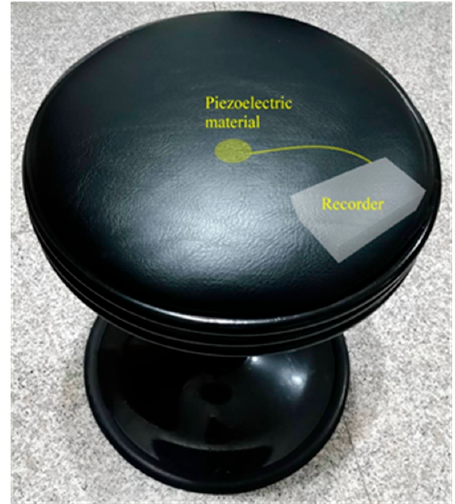
Figure 1. Architecture of the detection system.